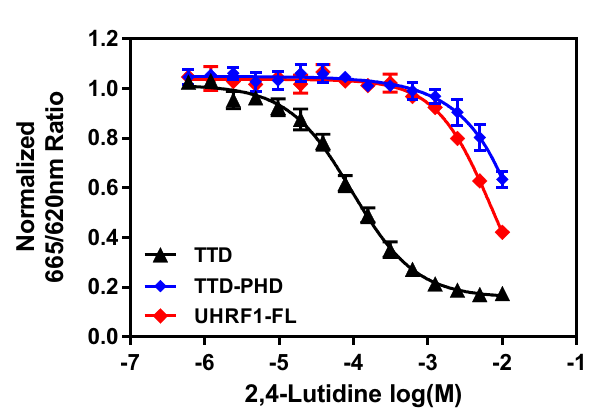
Figure 6. 2,4-Lutidine also inhibits TTD-PHD and UHRF1-FL activities. The TR-FRET assay indicated 2,4-lutidine only started to inhibit the binding of TTD-PHD and UHRF1-FL to the H3K9me3 peptide at mM